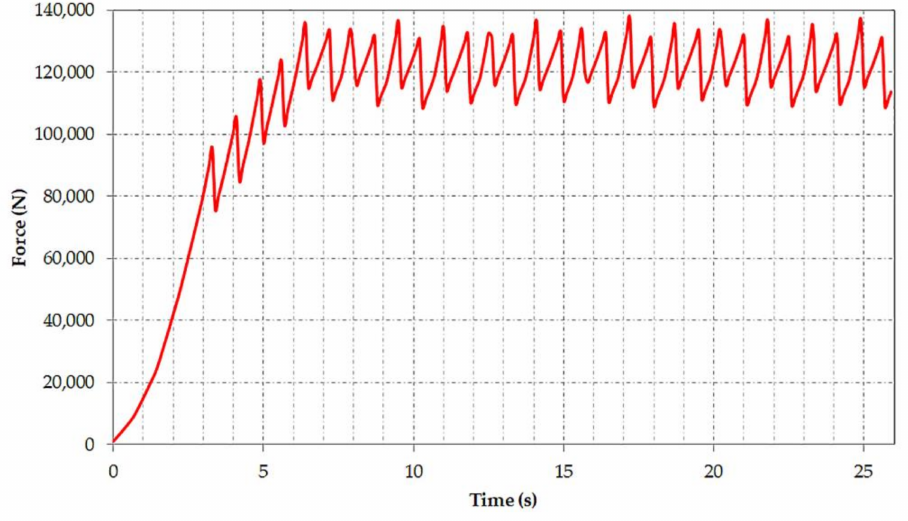
Figure 6. The variation in time of the vertical